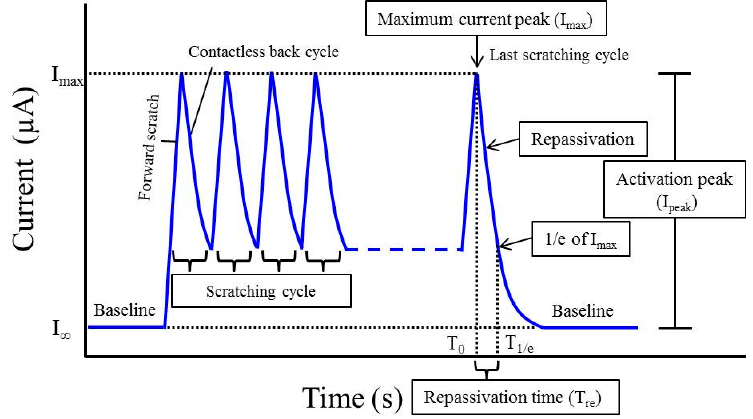
Figure 2. A typical fretting corrosion plot.